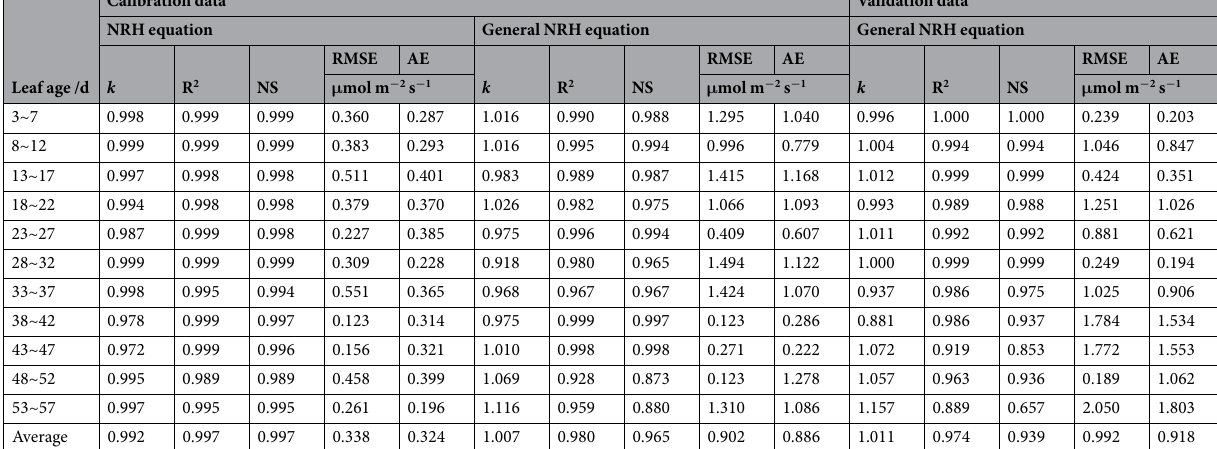
Table 1. Performance of the non-rectangular hyperbola (NRH) and general NRH equations in predicting photosynthetic light response (PLR). k , R 2 , NS, RMSE and AE denote slope of linear regression, coefficients of determination, Nash-Sutcliffe coefficient, root mean square error and average absolute error of net photosynthetic rates calculated based on the NRH and general NRH equations.